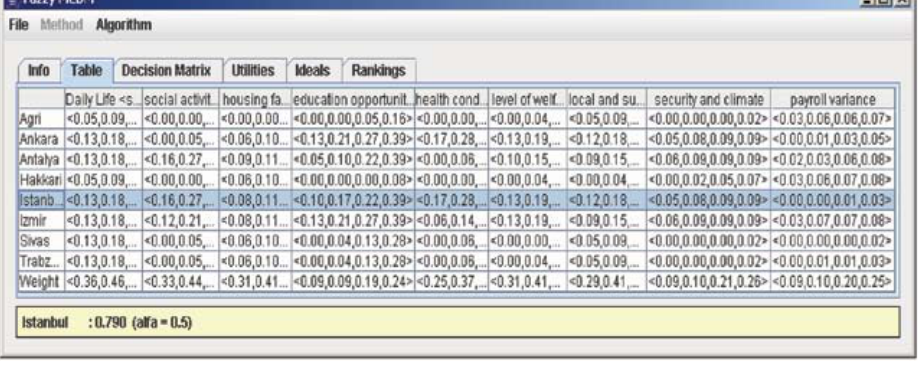
Fig. 7. Reduced weights for C 4 , C 8 and C